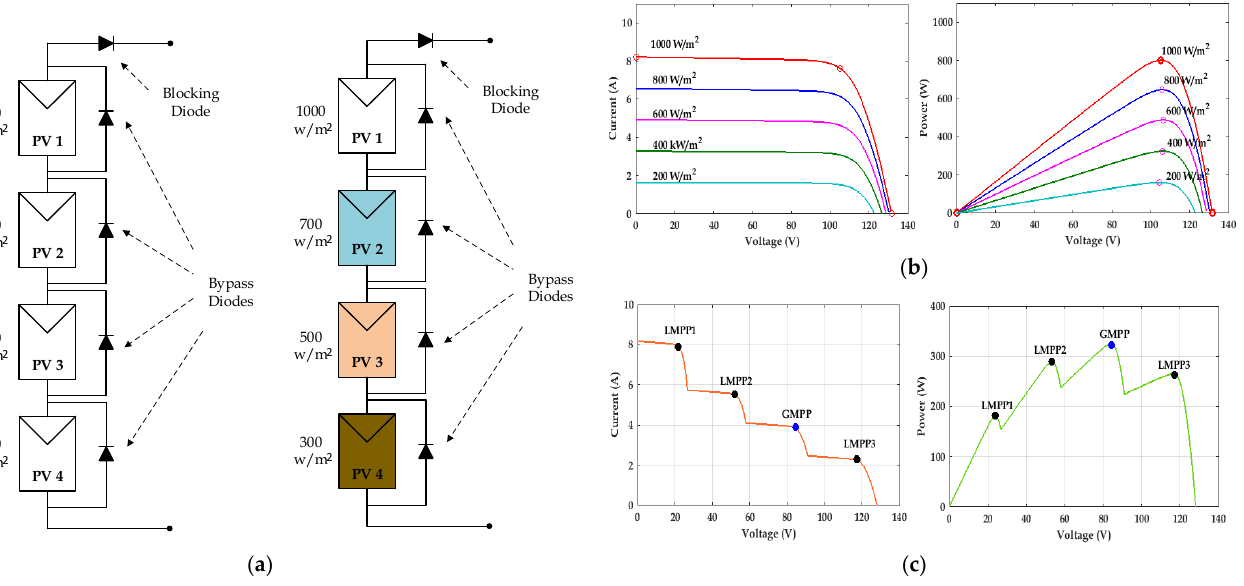
Figure 3. ( a ) Solar array in both scenarios. ( b ) P–V and I–V curves for uniform irradiation and ( c ) P– V and I–V curves for non-uniform